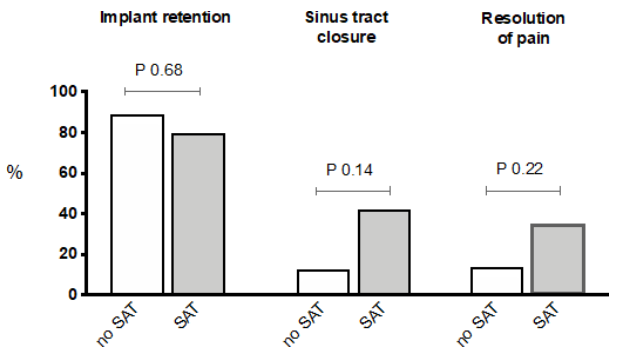
Figure 1. Clinical outcome of patients with and without SAT (sup- pressive antibiotic